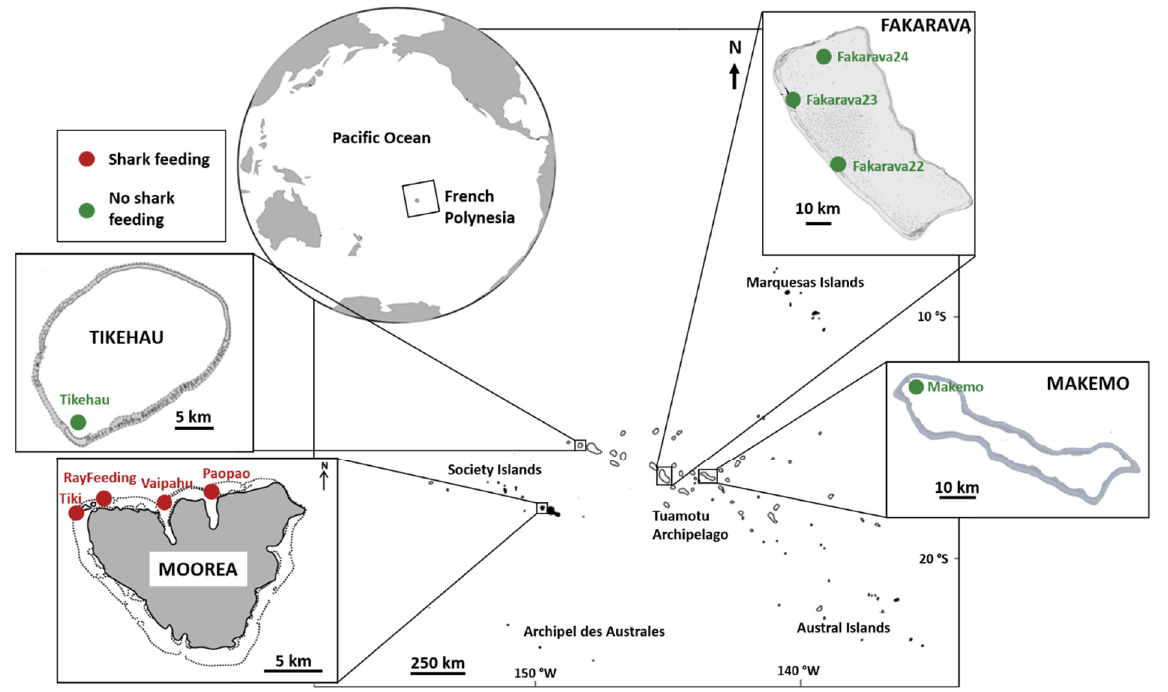
Figure 1. Map of French Polynesia, with the global situation and close-ups on Moorea, Fakara, Tikehau, and Makemo. Sampling sites are designated as the presence (red) or absence (green) of shark provisioning.